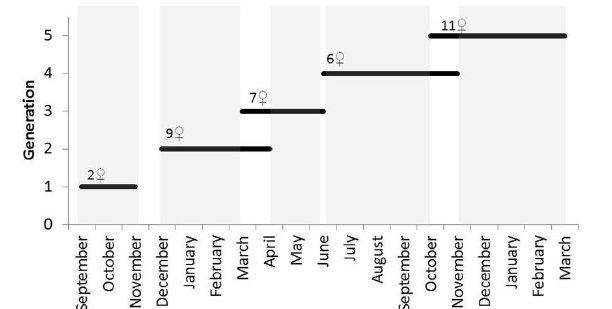
Fig 1. Nest succession of Euglossa annectans for two years between 2010-2012. During this time we recorded five generations. The horizontal bars show the length of time between a given generation when the first bee emerged until the period when the last bee from the same generation left the nest. The numbers over the horizontal bars followed by the symbol ♀ (female) indicate the number of active female during the generation. The light grey areas highlight the period of sororal (daughter-daughter) associations within one generation. Overlapping generations were observed among all